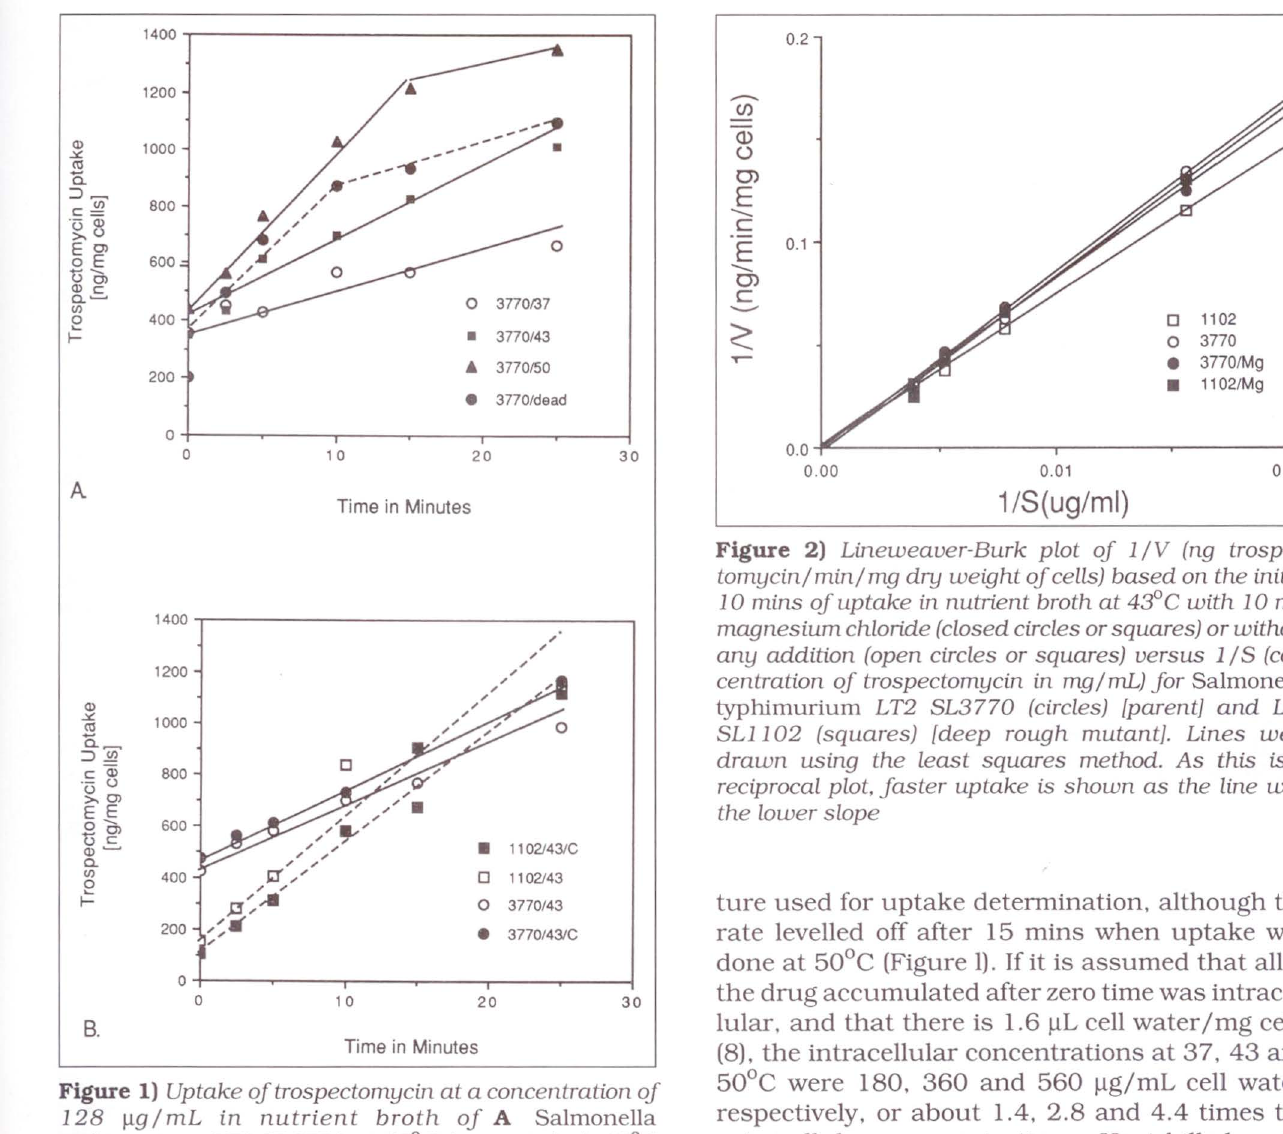
charide and outer membrane proteins described by Bryan et al (7).